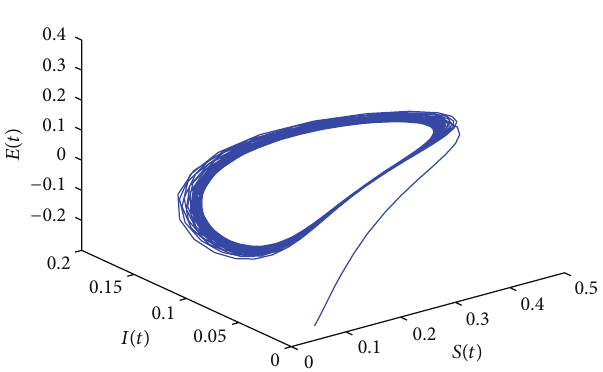
Figure 7: Limit cycle corresponding to the periodic solution in Figure 5 in the S - I - E